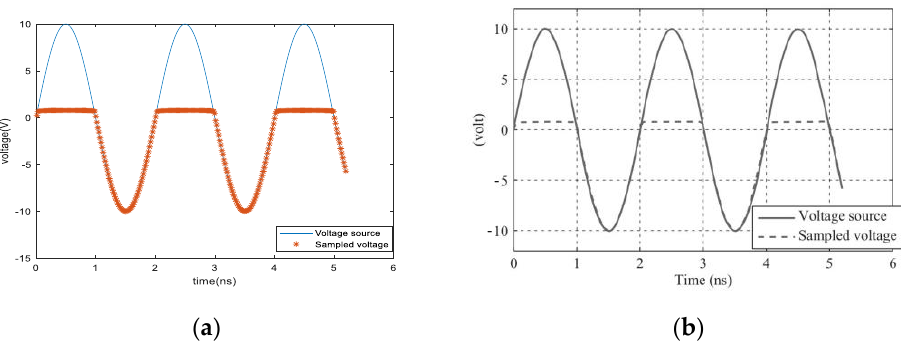
Figure 5. Excitation source waveform and sampling voltage waveform: ( a ) simulation result; ( b ) reference result.